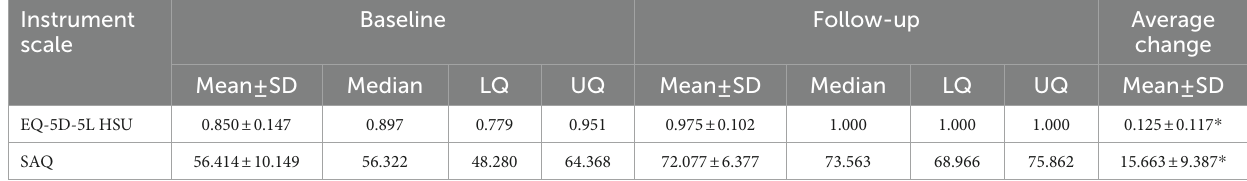
TABLE 2 Summary statistics of EQ-5D-5L HSU and SAQ ( N = 75). Instrument